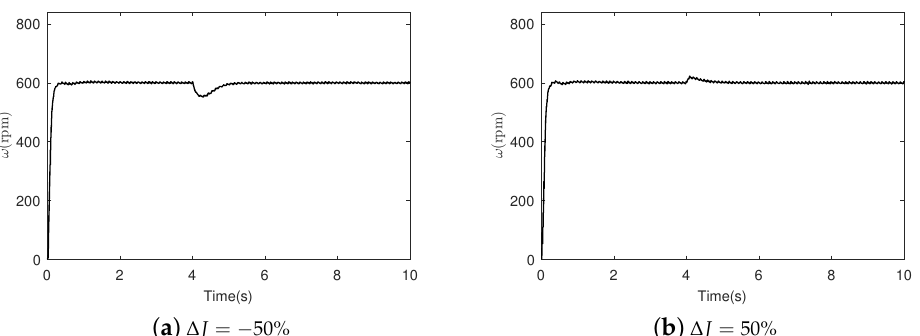
Figure 13. Speed response curves when the moment of inertia value changes